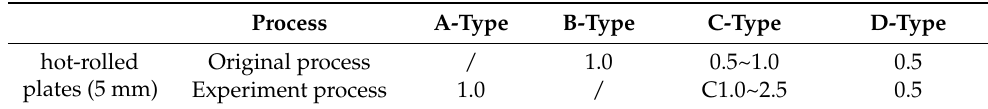
Table 13. Rating results of inclusions in hot rolled plates before and after the implementation of the process on phase